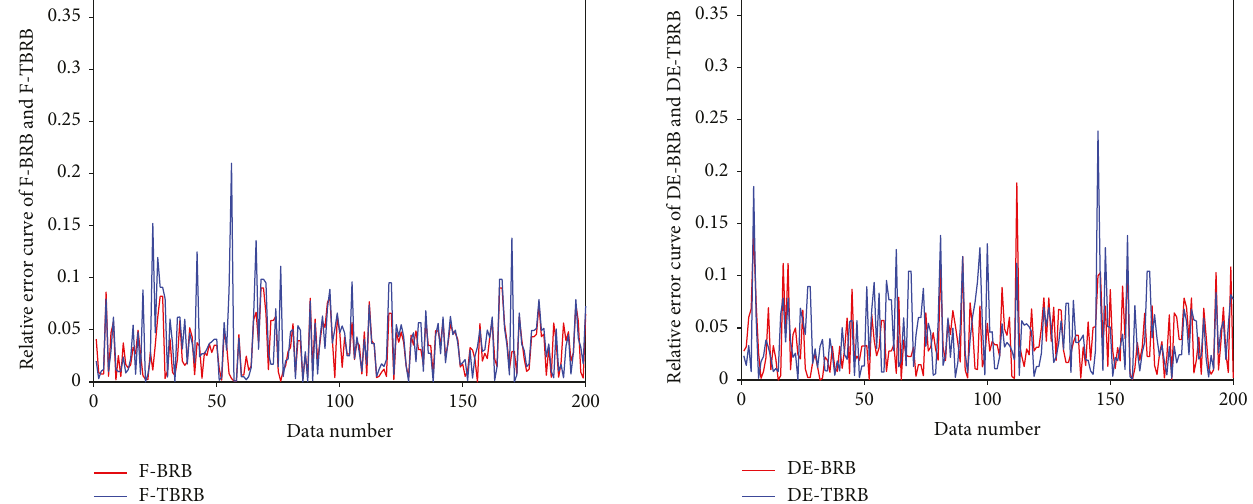
Figure 10: The relative error of F-BRB and F-TBRB.